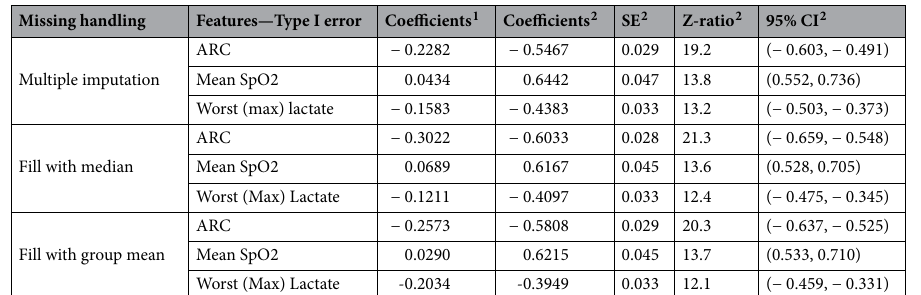
Table 2. Features selected for Type I error when using cutoff 0.33. 1 Coefficients calculated from fitting the Lasso feature selection model. 2 Coefficients, SE, Z-ratios, and the 95% CIs calculated by ordinary logistic regression using the selected features from Lasso; features sorted by Z-ratios, where Z-ratio = | Coefficient / SE | .